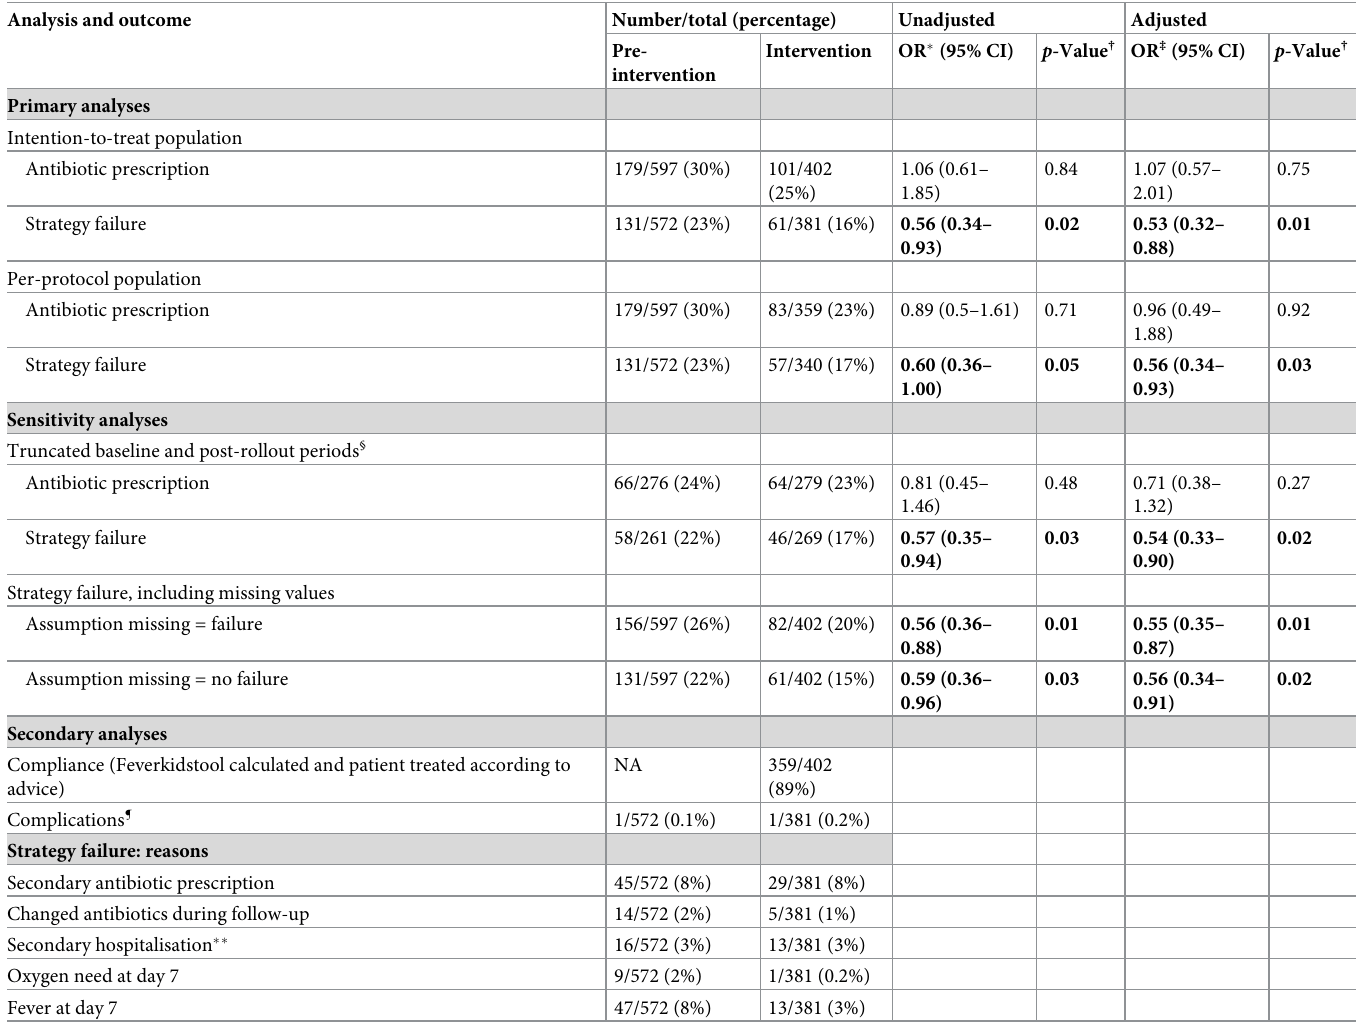
Table 2. Antibiotic prescription and strategy